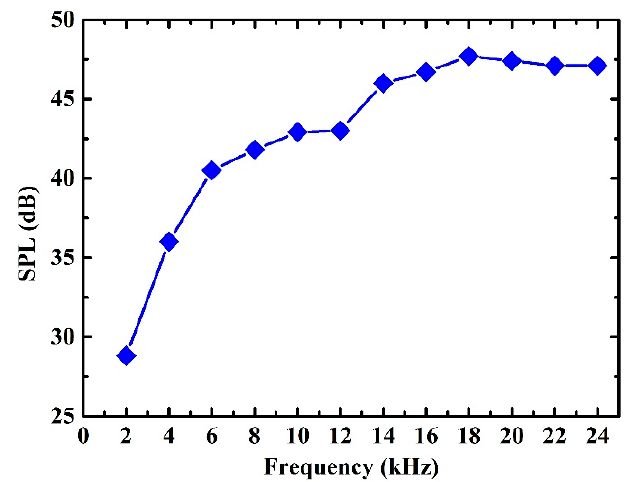
Figure 8. Relationship of SPL with the frequency.